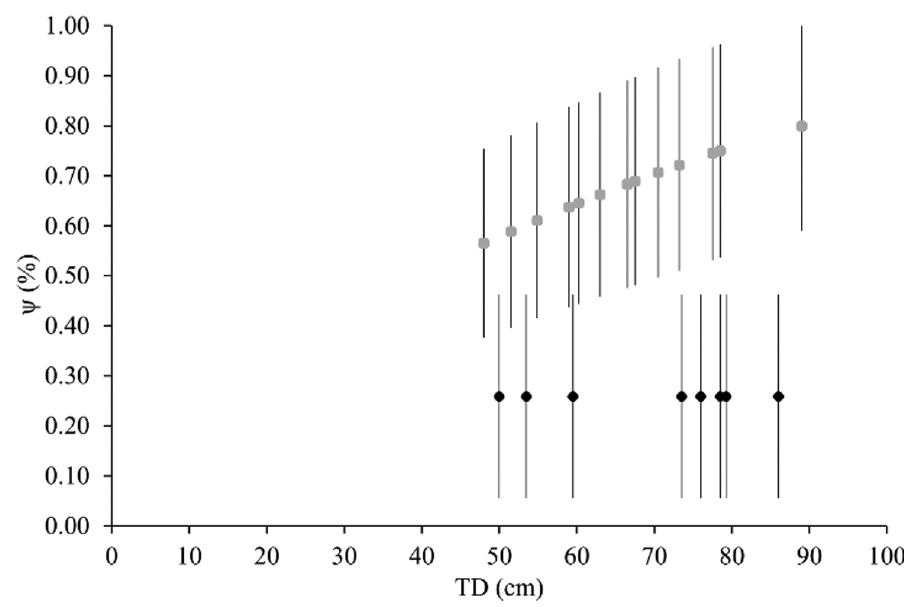
Figure 9. Estimated occupancy probability ( ψ ) in relation to tree species (dark grey = Quercus cerris ; light grey = Quercus robur ) and tree diameter (TD). Vertical bars show the standard errors (SE). Detection/ non-detection data were recorded during surveys of baited bottle traps located in the Bosco della Fontana from May to July